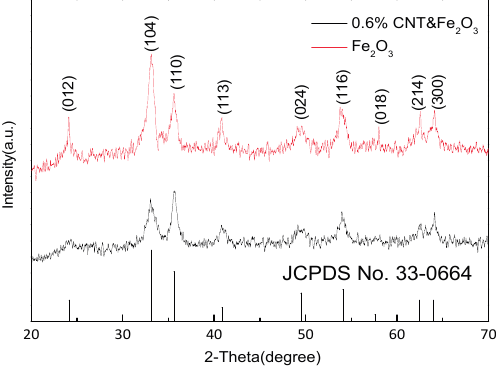
Figure 2. XRD pattern of the iron oxide.